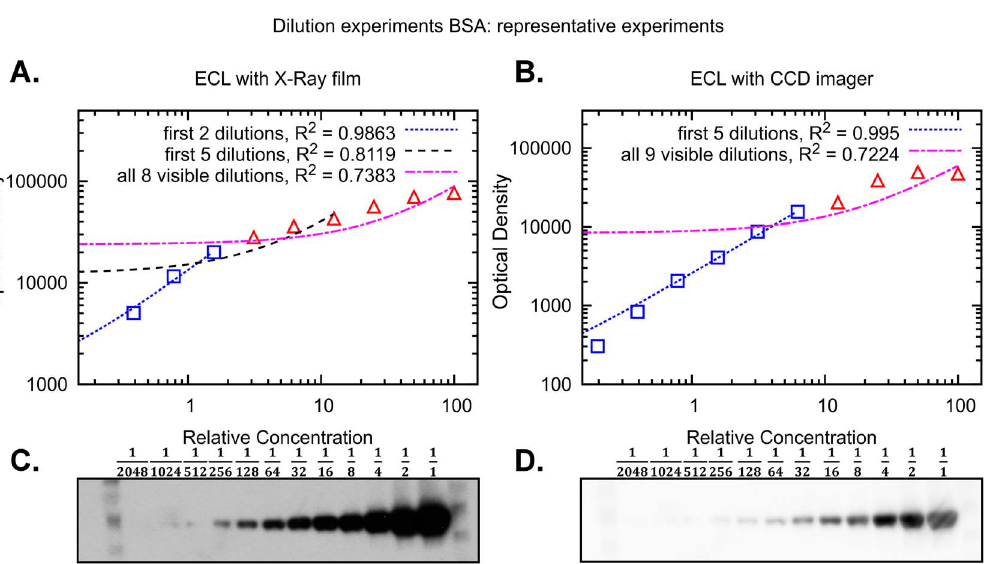
Figure 2. Signal linearity obtained by different Western blot detection systems. Representative experiments of Western blots containing 2- fold serial dilution of BSA. Shown are the representative results from 3 independent experiments. BSA was detected by (A,C) ECL with X-ray film and (B,D) ECL with CCD imager. Blue squares indicate data points that are linear, while red triangles indicate data points outside the linear range of detection. To highlight linear and non-linear data we use linear trend lines, reporting the coefficient of determination R 2 . In (A,B) data are in log-log scale to improve visualisation.